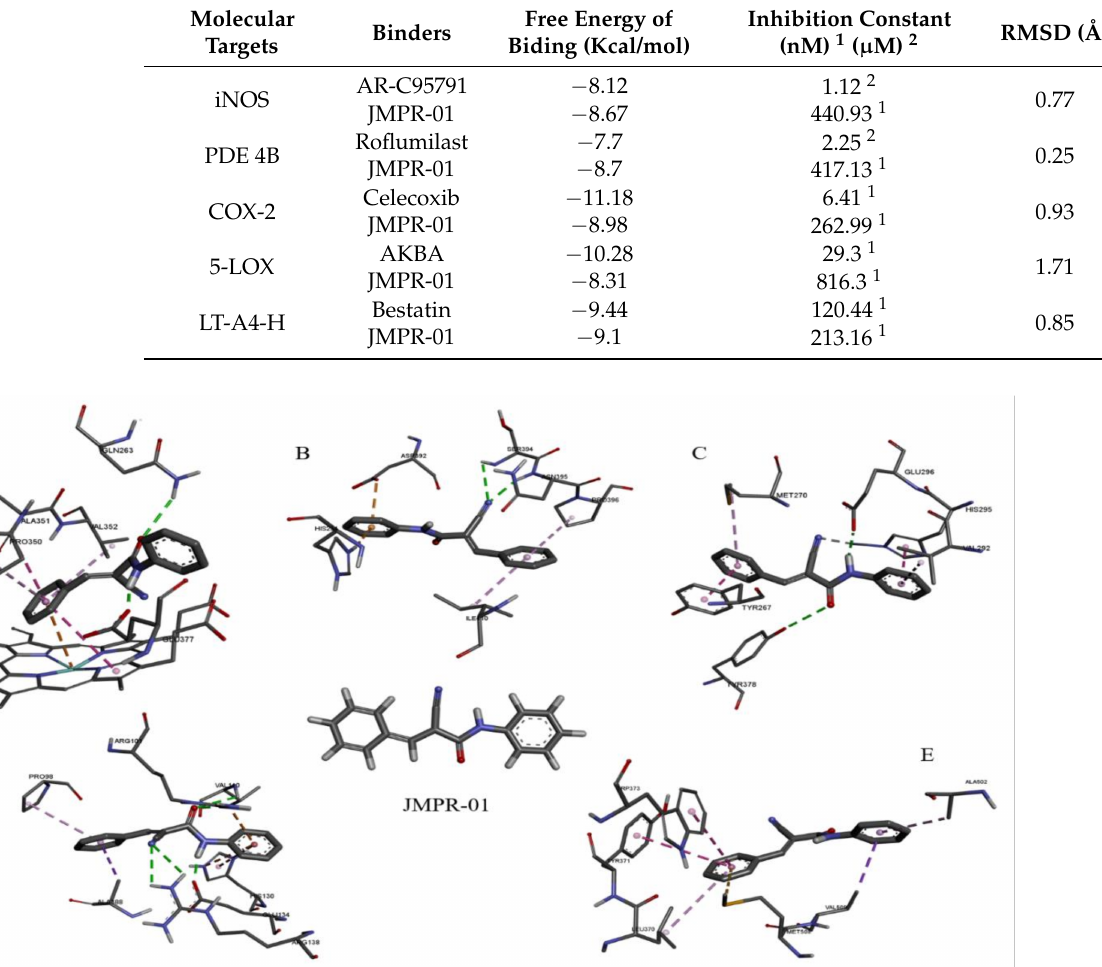
Table 2. Binding free energy and inhibition constant values of target-ligand complexes.